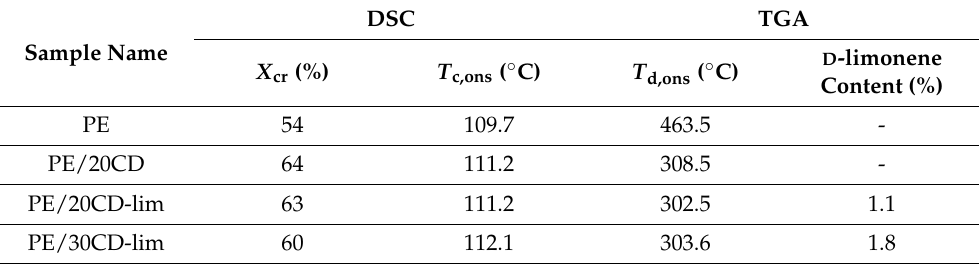
Figure 4. Thermogravimetric analysis (TGA). Mass loss upon heating in nitrogen atmosphere of PE/CD-lim composites compared to pure PE matrix. Table 1. Crystallinity degree, crystallization onset temperature ( T c,ons ), degradation onset tempera- ture ( T d,ons ), and D -limonene content in the PE/CD-lim composites.